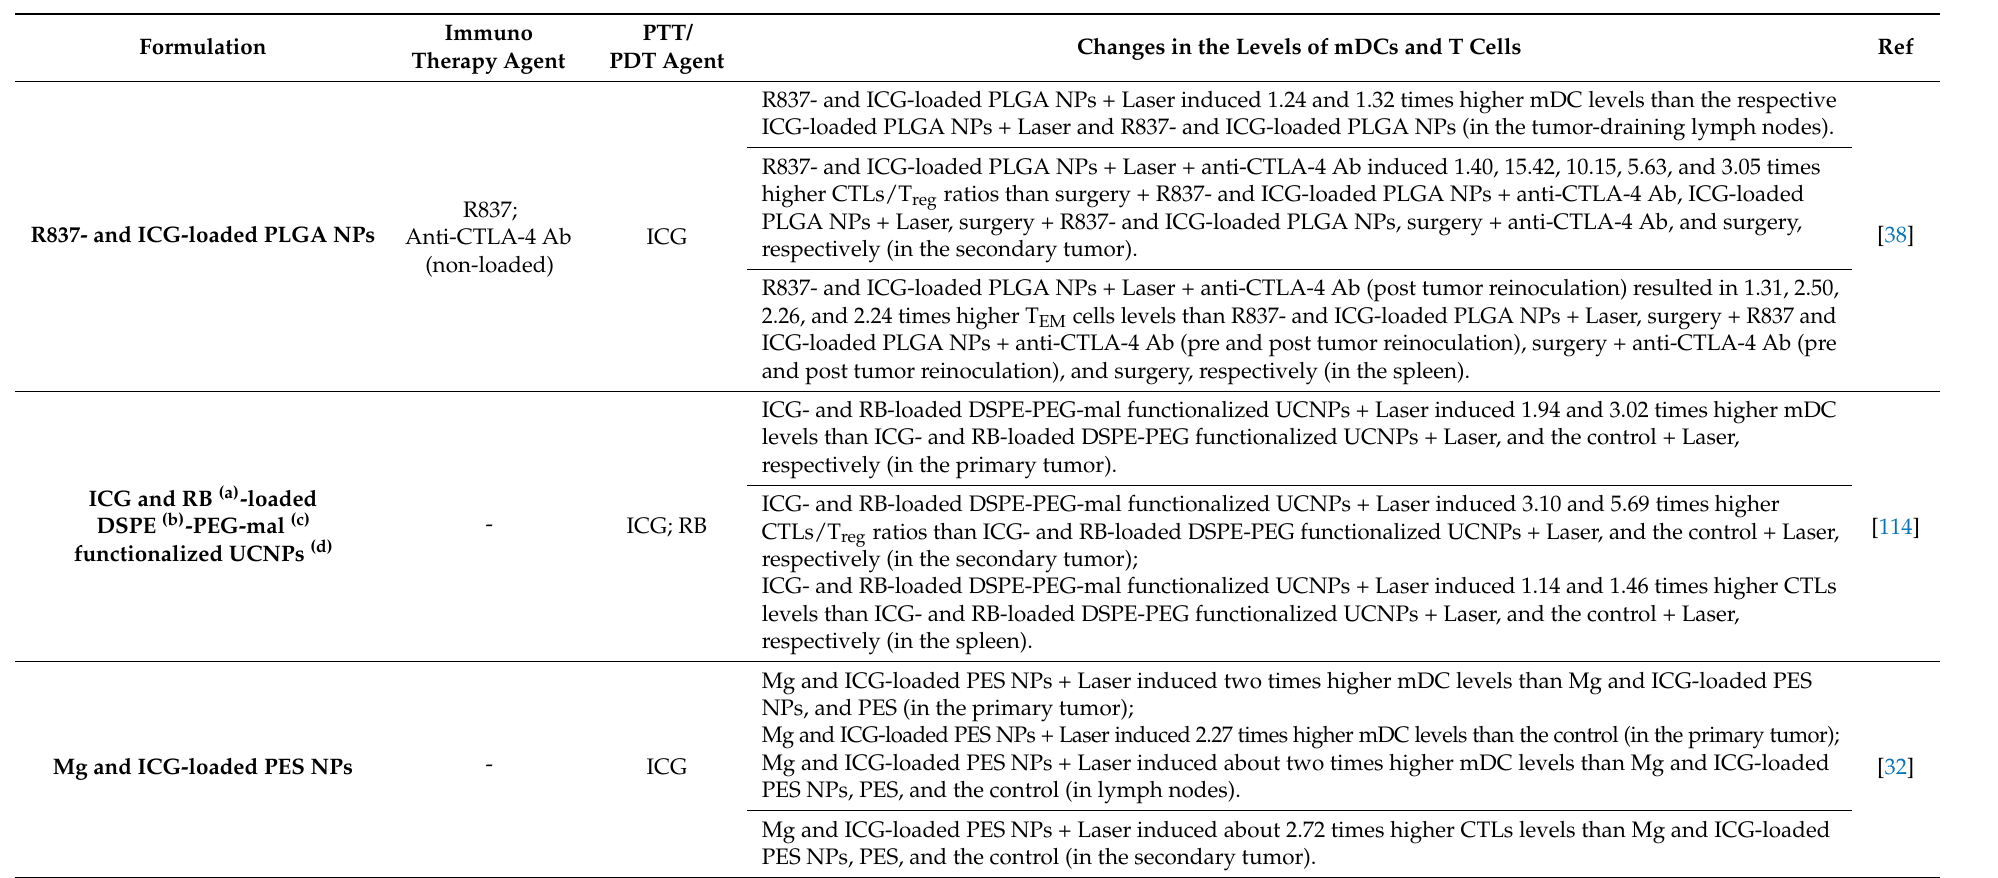
Table 1. Outcome generated by the immuno-PTT/PDT mediated by ICG-based nanomaterials in the levels of mDCs and T